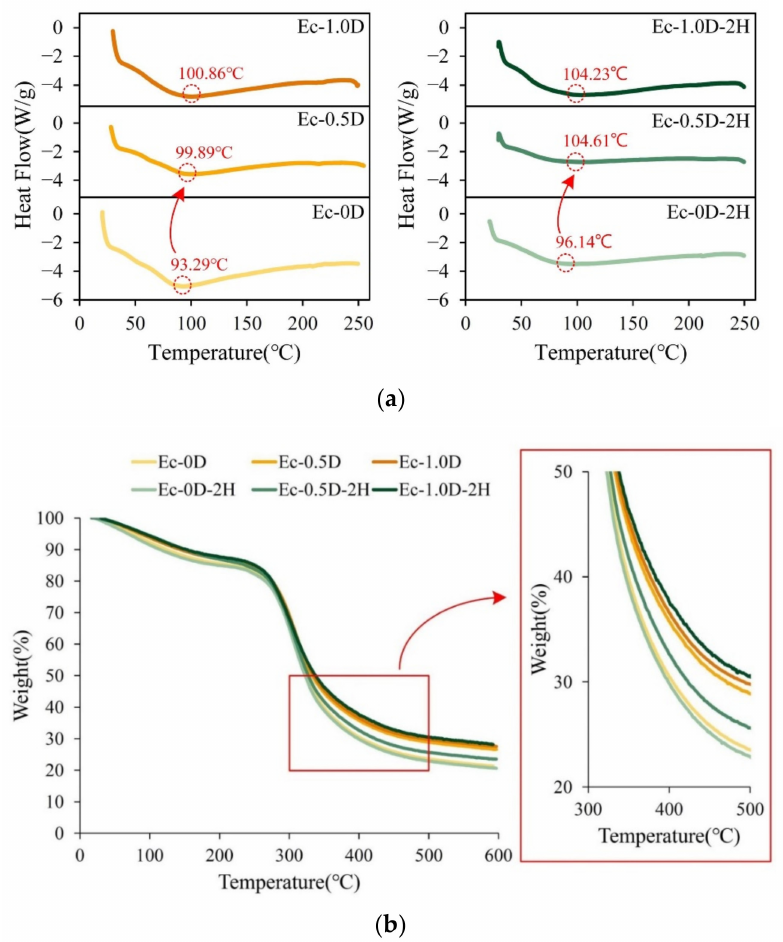
Figure 5. DSC analysis ( a ) and TGA ( b ) of different hydrogel